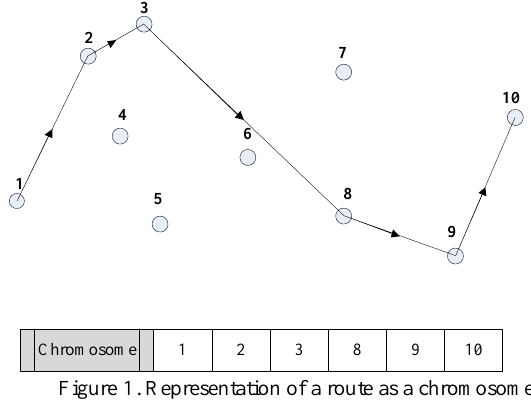
Figure 1. Representation of a route as a